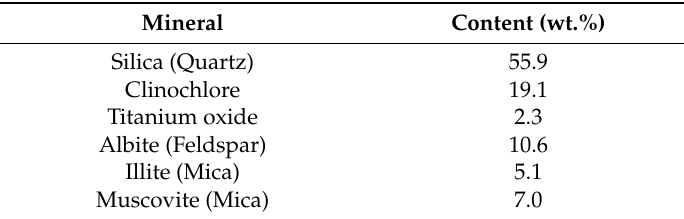
Table 1. Mineral content (wt.%) for slate tiles (Valdeorras variety) estimated using a semiquantitative X-ray diffraction (XRD) methodology.